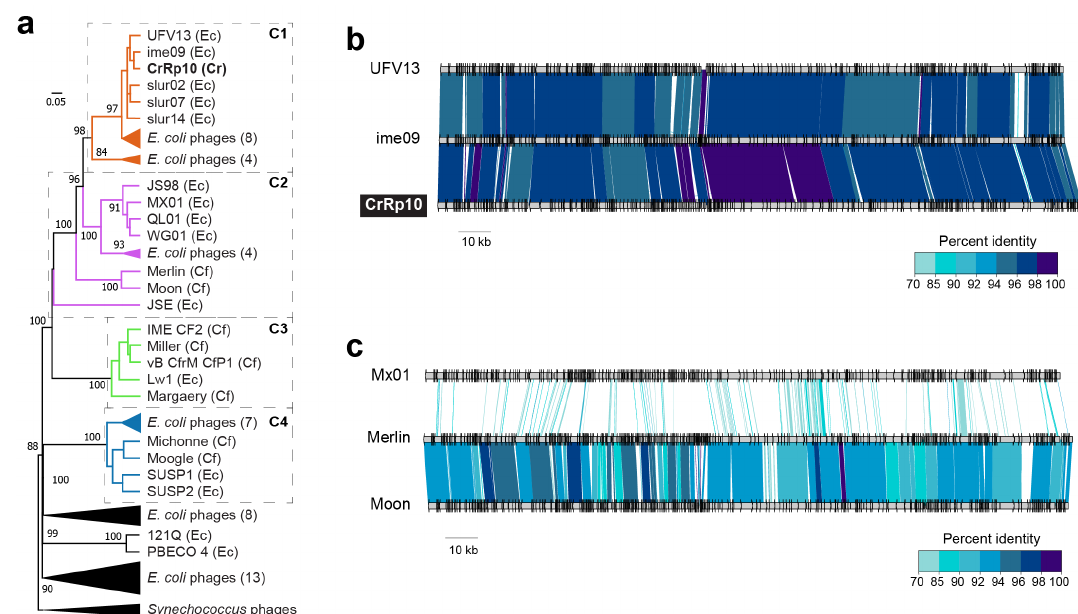
Figure 5. Phylogenetic relationships among Citrobacter and Escherichia myoviruses. ( a ) Tree assembled with complete genome sequences of myoviruses that infect C. rodentium myoviruses (Cr), C. freundii (Cf) and related E. coli (Ec). The tree is rooted using Synechococcus phages and bootstrap values at nodes defining percent confidence of 100 replicates. Phylogenetic clades (C1–4) have strong bootstrap support of > 70%. ( b ) Complete genome nucleotide alignment of members in C1, which includes CrRp10. ( c ) Genome alignment of members in C2, including the closest related Citrobacter phages, Merlin and Moon, which infect C. freundii